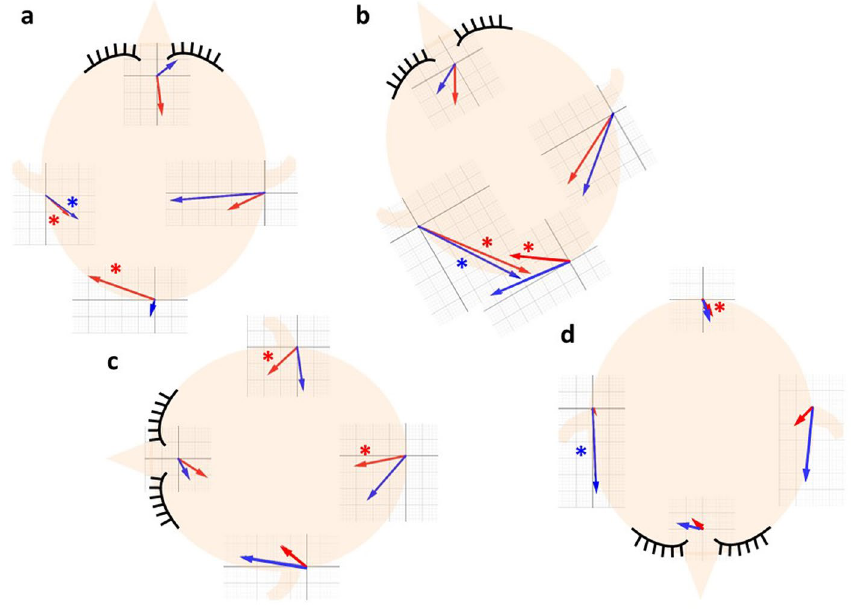
Figure 7. A schematic diagram of x–y vectors of the distance errors. An illustration of the head showing the imaging space. The vectors indicate the direction of the deviation from the imaging point to the patient point in the AIR method (red arrows) and the SMR method (blue arrows), respectively. Asterisks show the significant differences between x- and y-coordinates using an analysis of variance with a post hoc Turkey–Kramer test. ( a ) the supine position; ( b ) the head-rotated supine position; ( c ) the lateral position; ( d ) the prone